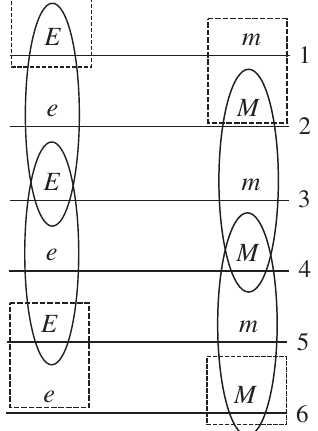
FIG. 3. Coupled-layer construction. Each layer is a SET phase with Z 2 topological order. E and M particles transform non- trivially under symmetry G , while e and m transform trivially. Composite particles indicated by ovals are condensed to obtain a d ¼ 3 SPT phase (which may be the trivial SPT phase). The particles in dashed boxes remain deconfined and uncondensed, and give rise to surface SET phases at the top and bottom surfaces. By choosing the fractionalization classes of E and M , surface SET phases with any desired symmetry fractionalization pattern can be realized by this